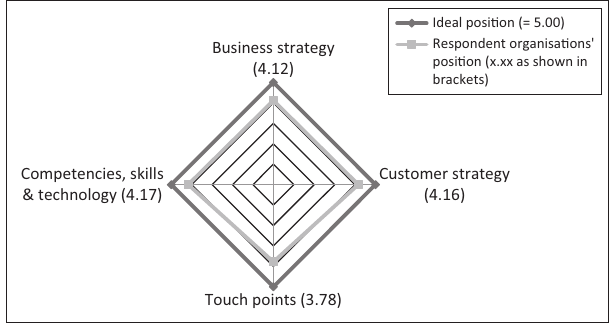
FIGURE 2: Level of factors preceding readiness for customer relationship management within respondent TABLE 2: Frequency distribution of responses to items measuring customer relationship management readiness.